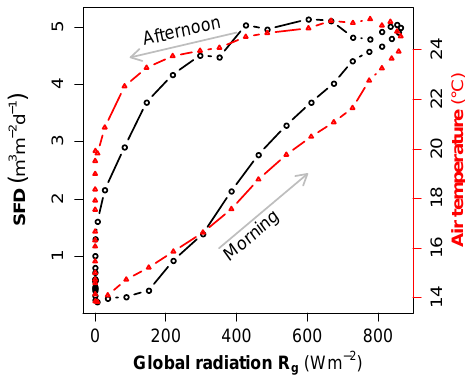
Figure 7. Hysteresis of sap flux density (left y axis) and air temper- ature (right y axis, red) plotted as a function of global radiation at the field site G1. Data are half-hourly values over one sunny sum- mer day (7 July 2013). Sap flow data are taken from a beech (tree 1) at site